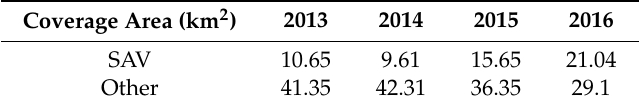
Coverage Area (km 2 ) 2013 Table 6. Satellite-derived SAV coverage area in the south basin of Lake Biwa (2013–2016).